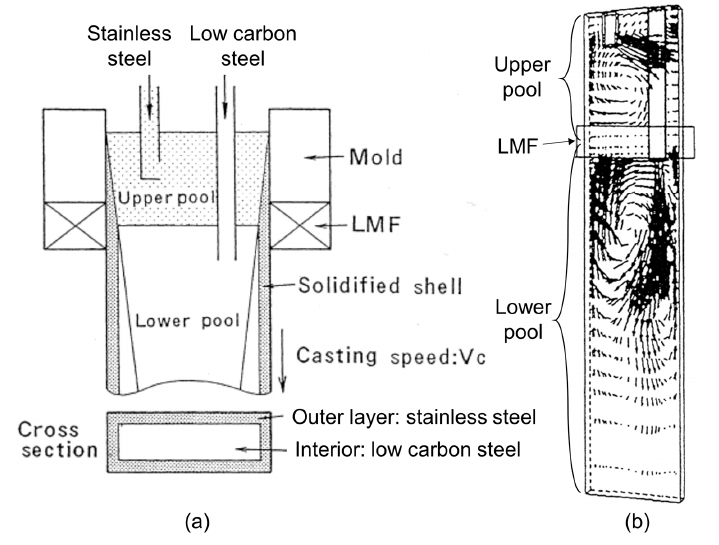
Figure 28. ( a ) Schematic of continuous casting and ( b ) flow patterns in the mold and strand region with Level DC Magnetic Field (LMF) for clad steel slabs